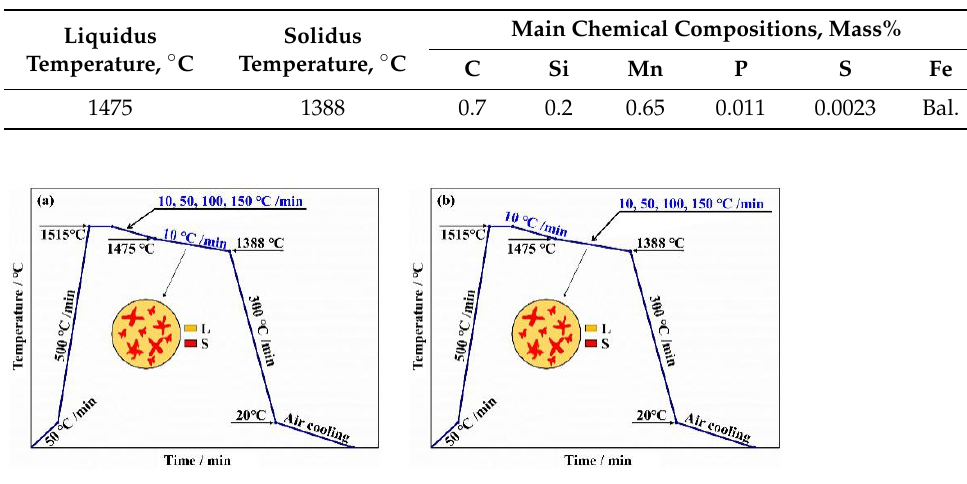
Figure 1. Thermal scheme used in the present experiment: ( a ) the cooling rate at the stage of the liquid–solid phase transformation remains constant, changing the cooling rate at the stage of superheat elimination; ( b ) the cooling rate at the stage of superheat elimination remains constant, changing the cooling rate at the stage of the liquid–solid phase transformation.